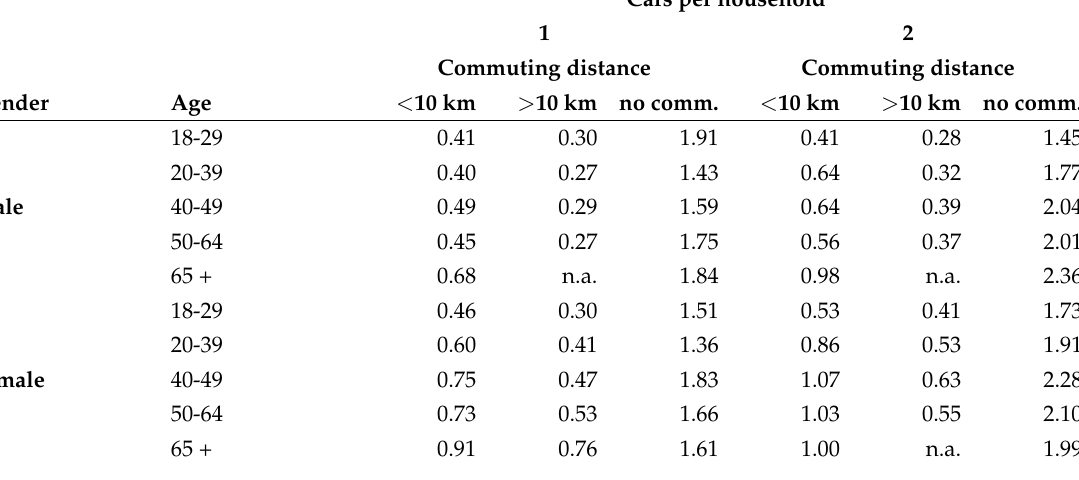
Table 4. EV penetration ratios for different socio-demographic groups of car owners ( < 1 means